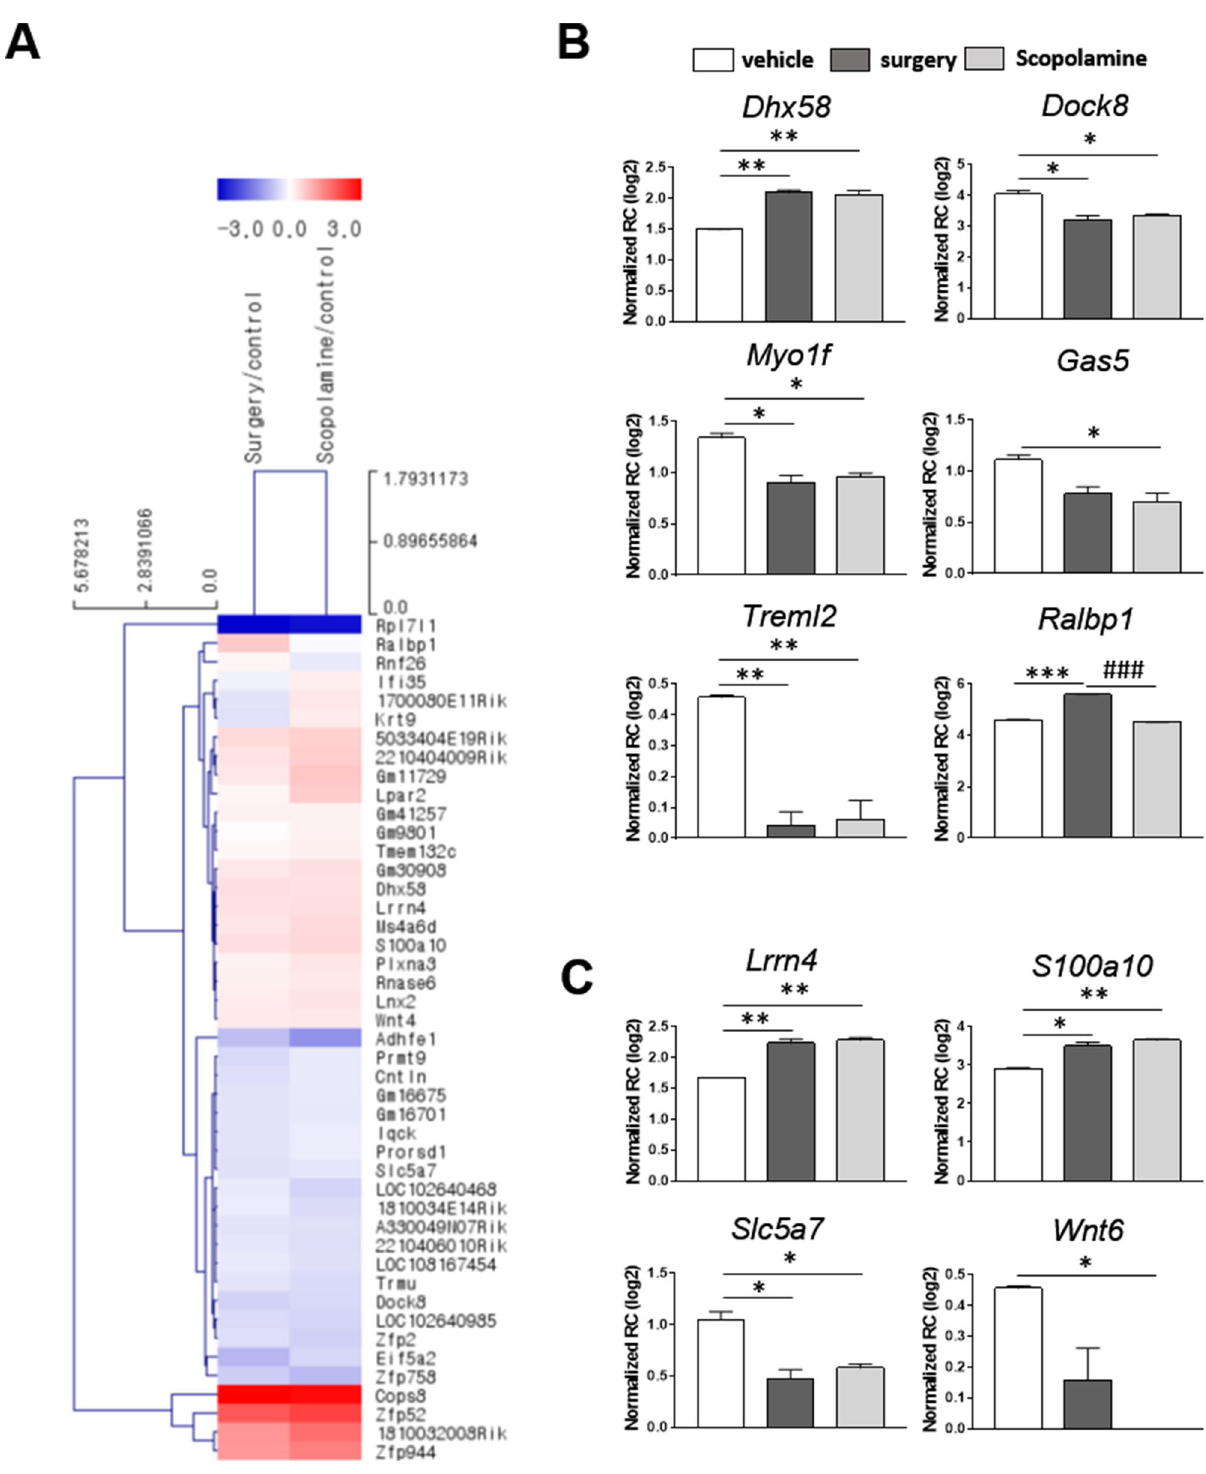
Figure 3. RNA sequencing transcriptome analysis. ( A ) Hierarchical clustering of hippocampal samples from vehicle, surgery, and scopolamine-treated groups. Samples were clustered according to the gene expression profiles of differentially expressed genes between control, surgery, and scopolamine-treated mice, respectively. The clustering tree is shown on the left, and the sample clustering tree appears at the top. The color scale shown at the top indicates the relative gene expression levels, with red representing a high expression level and blue, a low expression level. ( B ) Differentially expressed mRNAs involving immune/inflammatory response, and ( C ) hippocampal functionality and nervous system after surgery or scopolamine treatment. Values are presented as mean ± SEM (n = 2–3). p values < 0.05 were considered significant ( *p < 0.05, **p < 0.01, ***p < 0.001 vs control (sham or vehicle), ###p < 0.001 vs